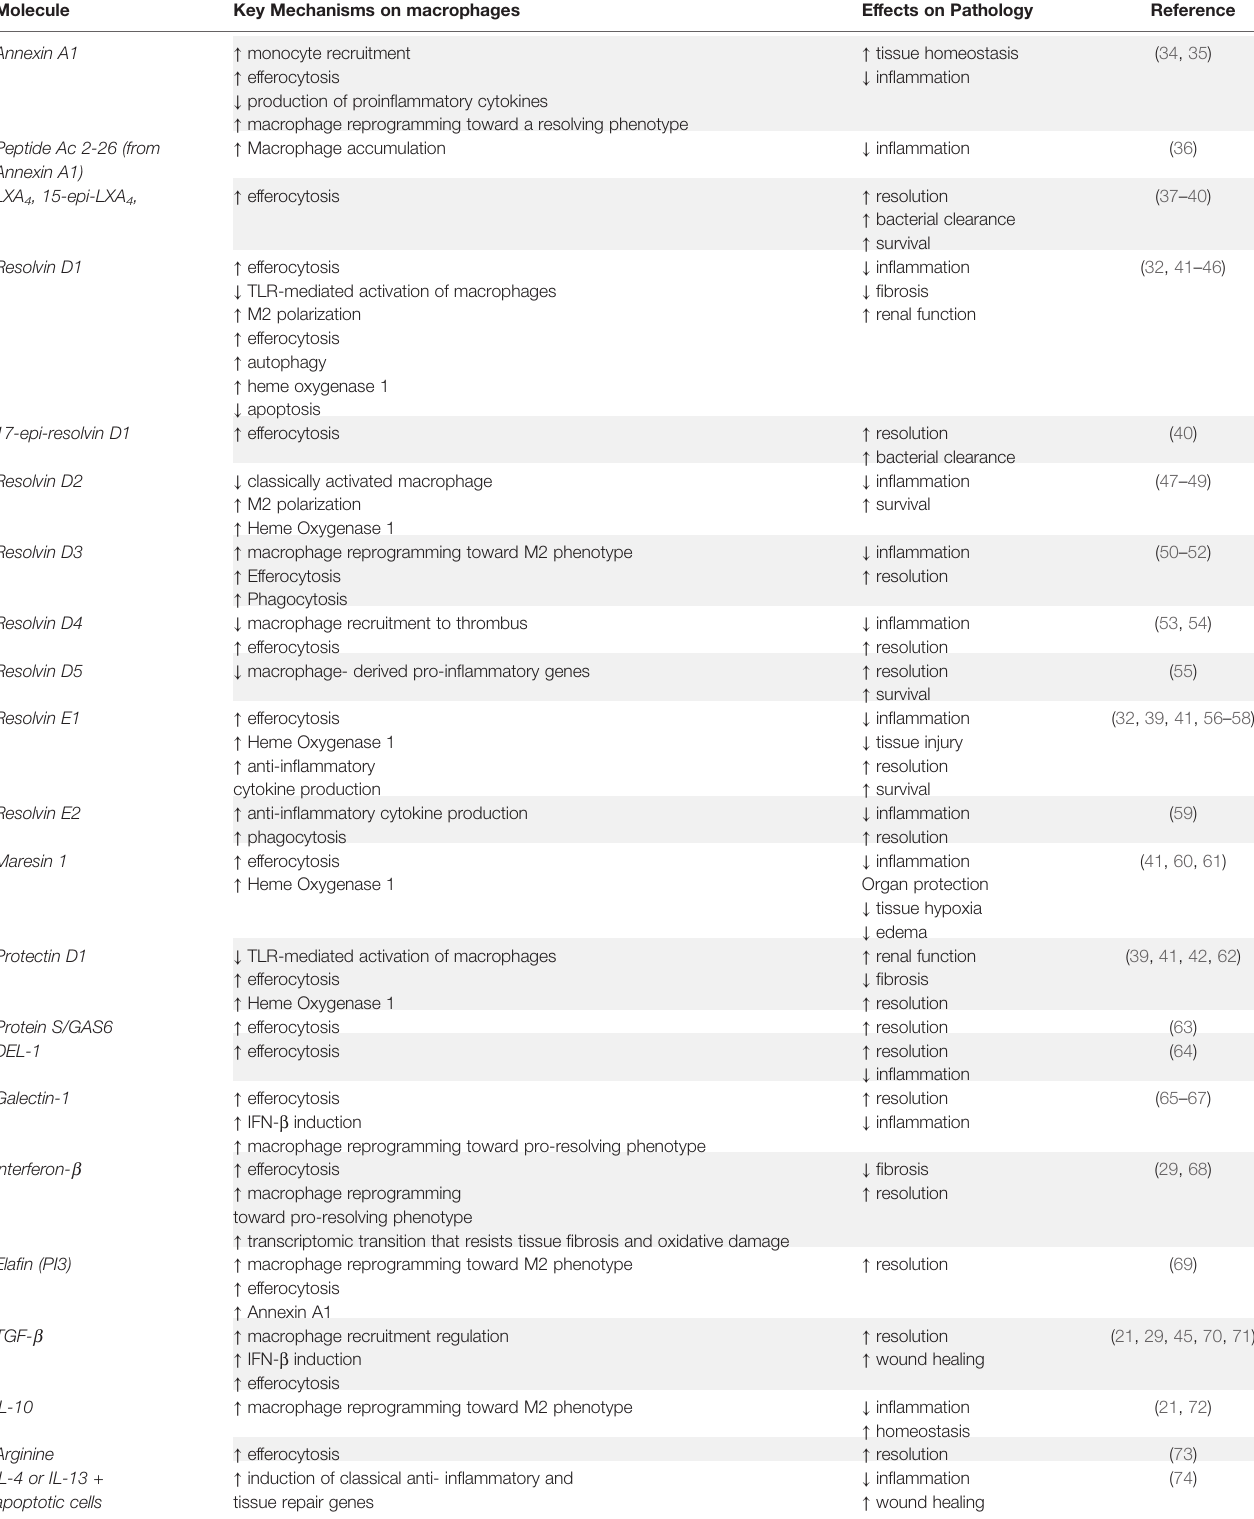
TABLE 1 | Pro-resolving effectors and macrophage reprogramming